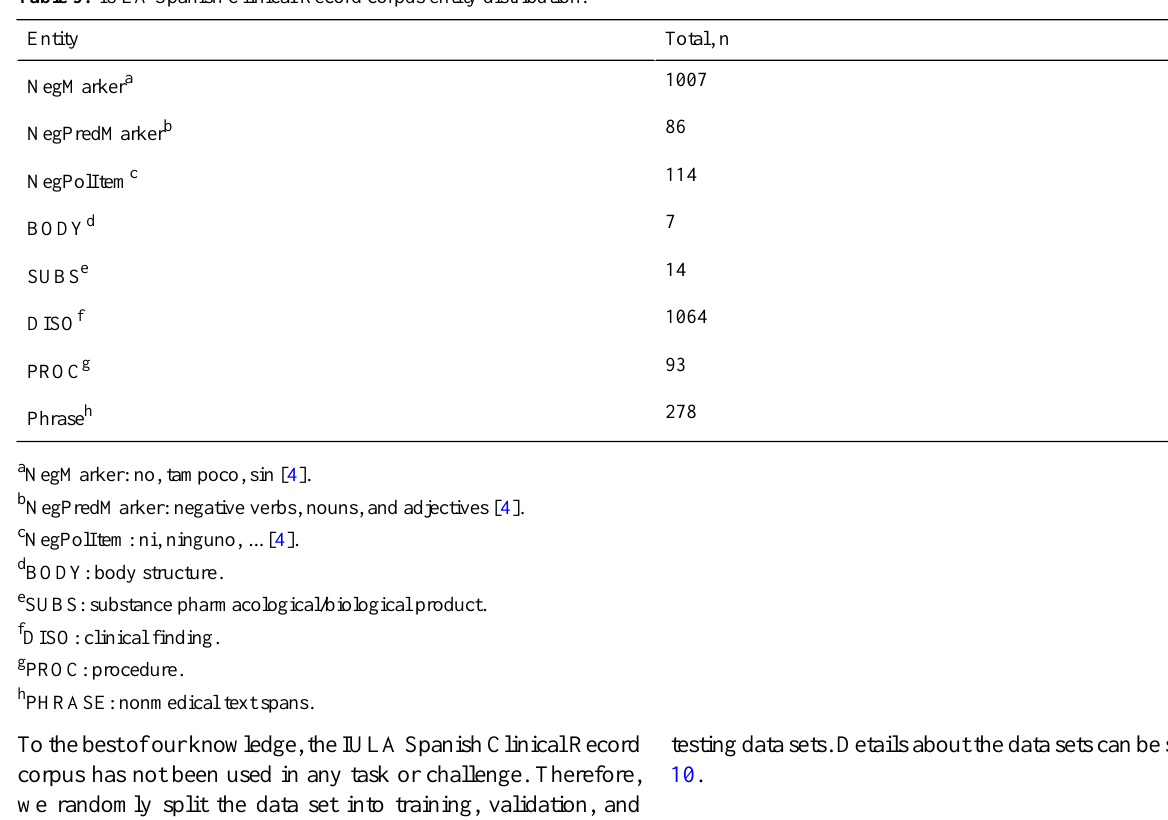
Table 9. IULA Spanish Clinical Record corpus entity distribution.